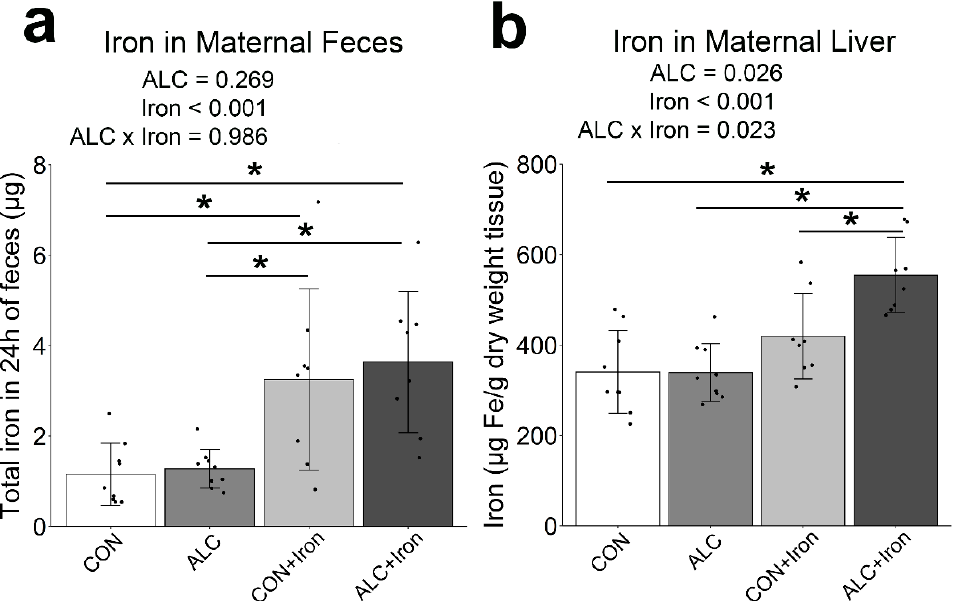
Figure 4. Alcohol exposure did not affect iron content in maternal feces or liver, whereas iron supplementation increased iron content in both feces and liver. Total iron in maternal feces collected over 24 h from GD19.5–20.5 ( a ), and total iron in perfused maternal liver at GD20.5 ( b ). Each data point (black dots) represents values for individual dams, and bars show the group means ± SD. * p < 0.05. ALC, alcohol exposed; CON, control.